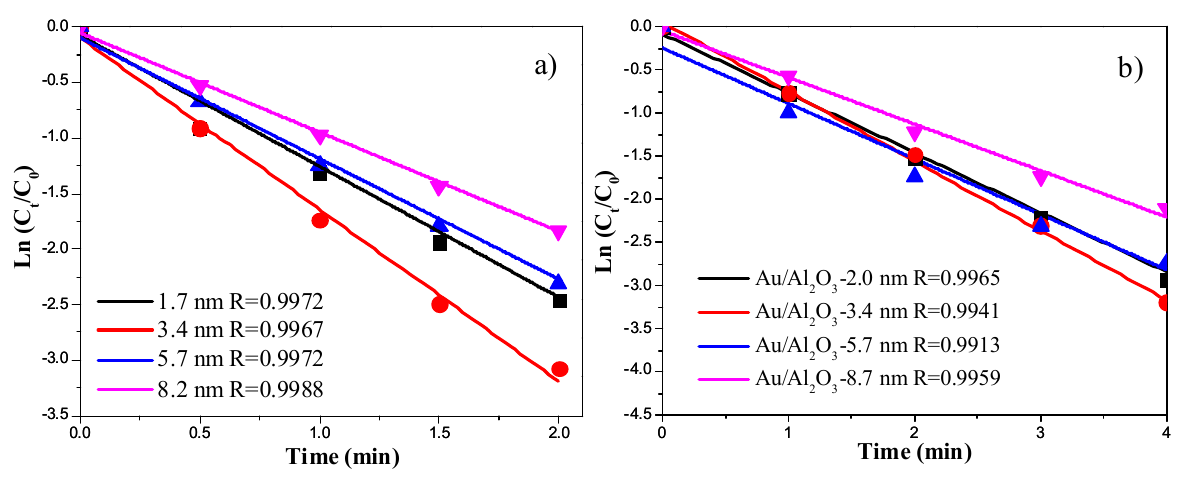
O with different Au particle sizes. 2 3